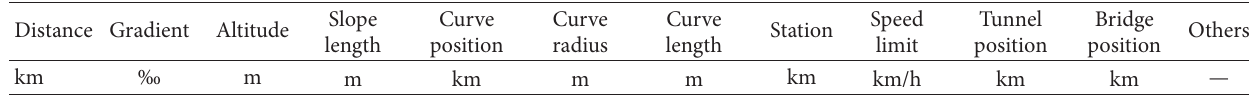
Table 3: Railways line parameters and units.